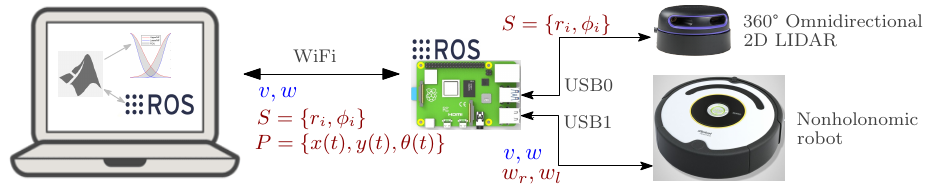
Figure 1. Composition of used system.